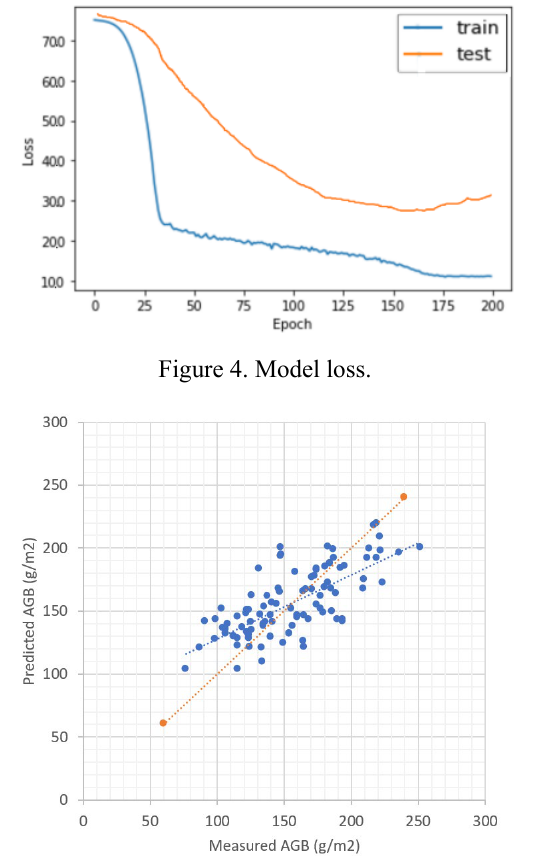
Figure 5. Scatter plots of the predicted against the measured biomass per plot (g/m 2